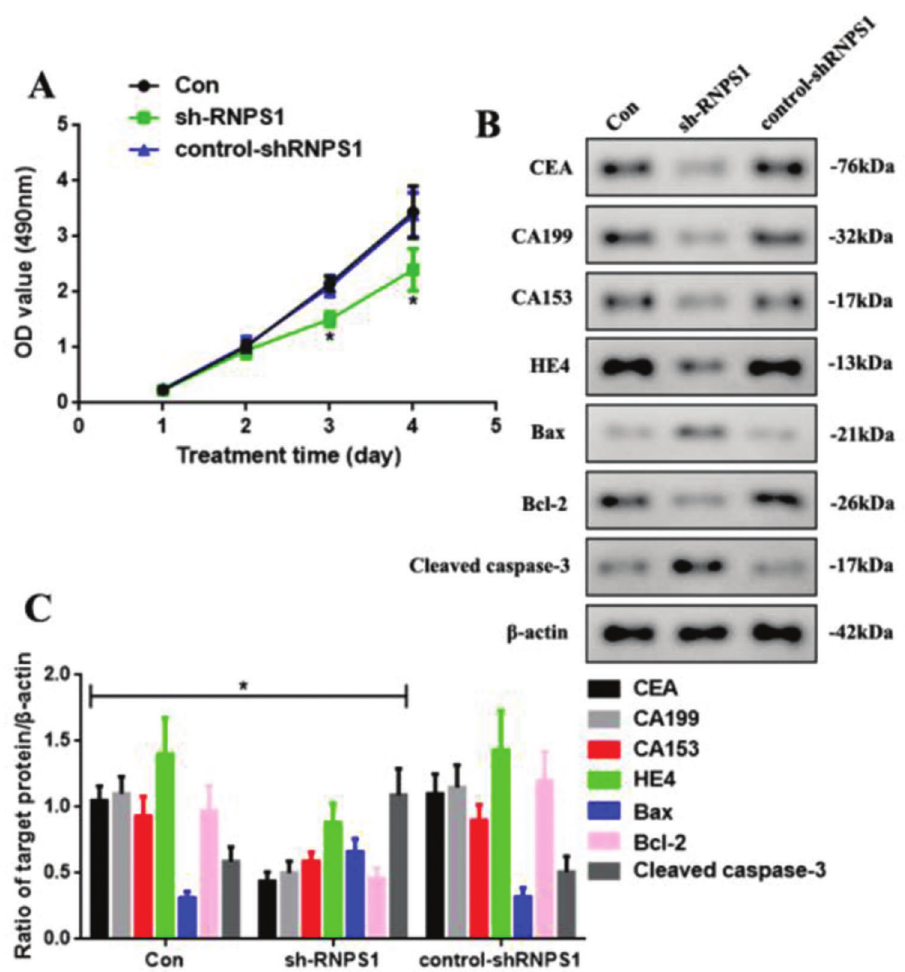
Figure 3 - (A) Proliferation assays of cells from the Con, sh-RNPS1. and control-shRNPS1 groups at 4 days. (B) Western blots for the analysis of the levels of CEA, CA199, CA153, HE4, Bax, Bcl-2. and cleaved caspase-3. (C) Quantitation of the levels of CEA, CA199, CA153, HE4, Bcl-2, Bax, and cleaved caspase-3. (n=6, * p o 0.05: sh-RNPS1 vs. other groups).